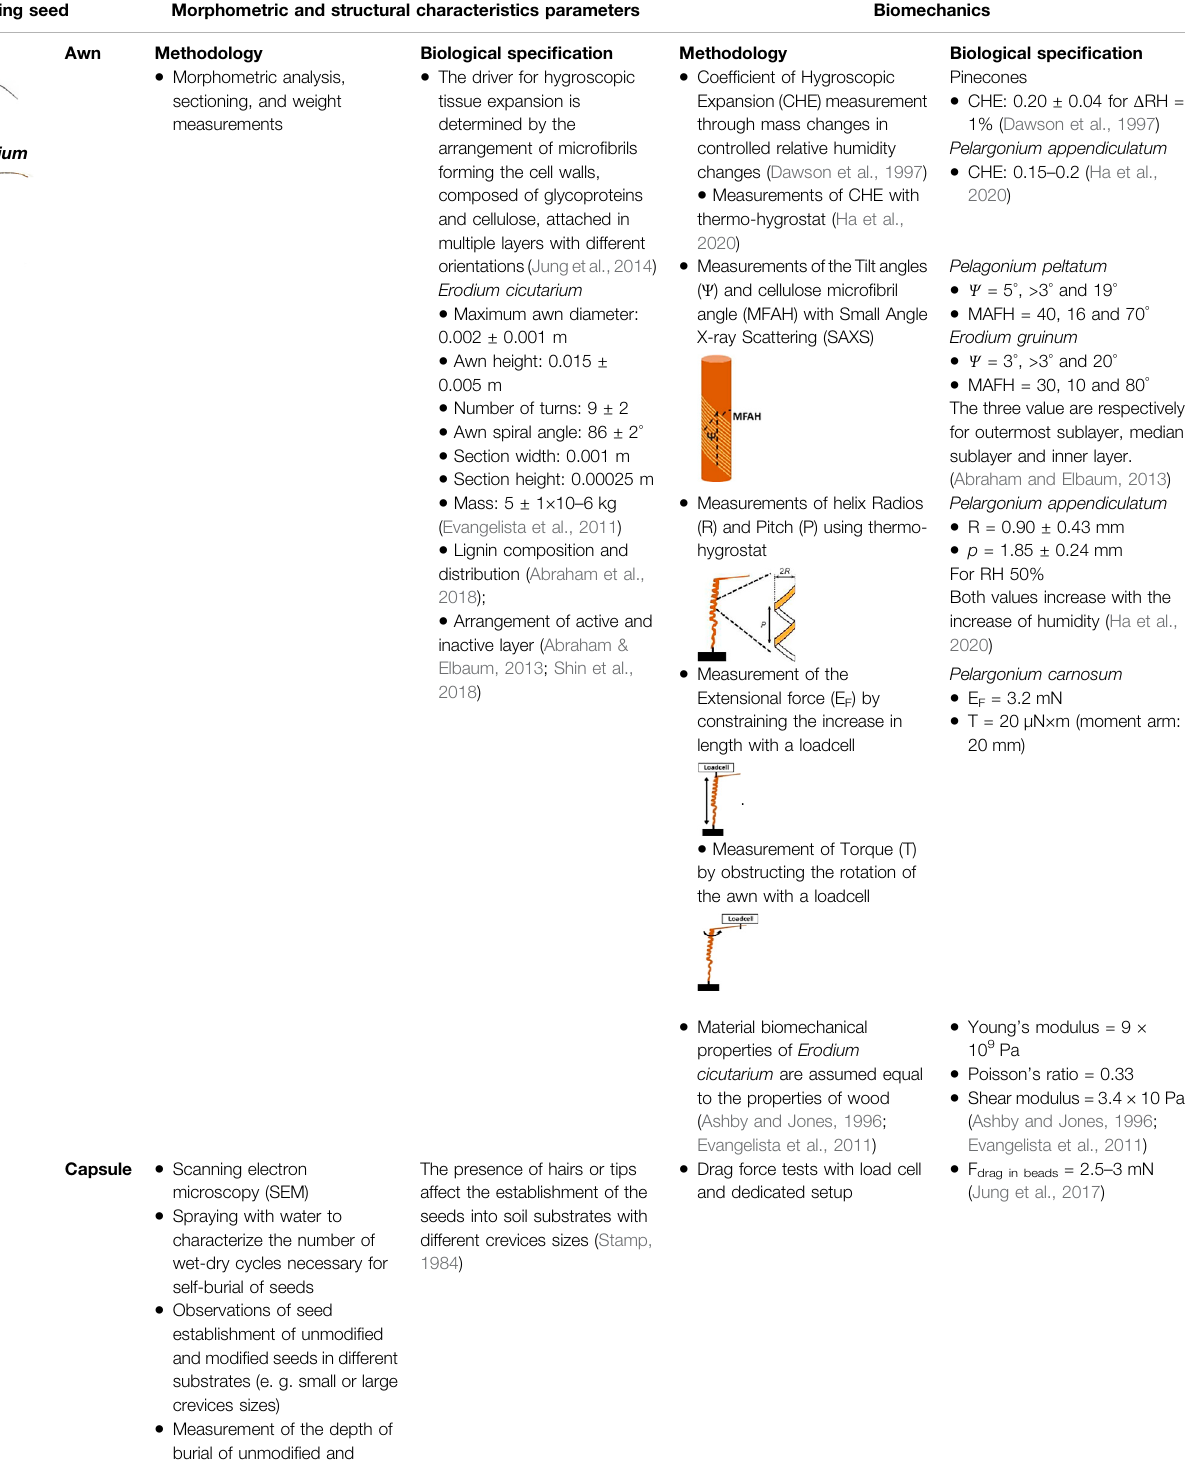
TABLE 1 | Summary of self-burying seeds biological features, measurements and characterization methods, and associated biological speci fi cations for soft robotic